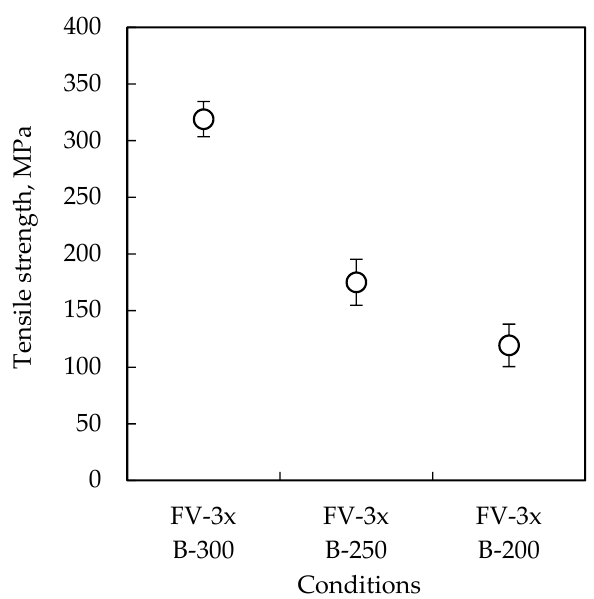
Figure 4. Tensile strengths of the formic acid vapor pre-treated chips at different bonding temperatures. Nine chips were tested in each condition.